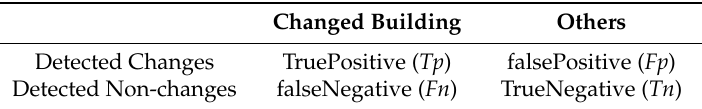
Table 3. Statistical accuracy comparison at the pixel level between the results produced by two approaches.